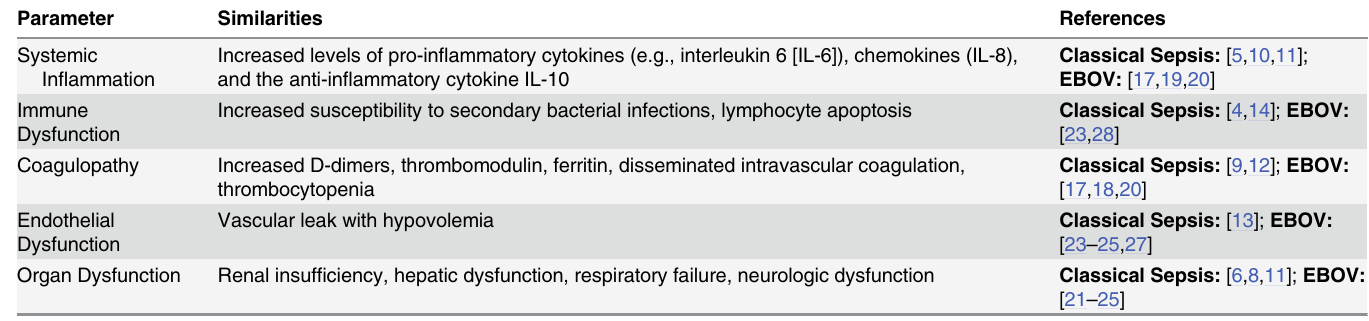
Table 1. Similarities between Severe and Fatal EBOV and Classical Sepsis.